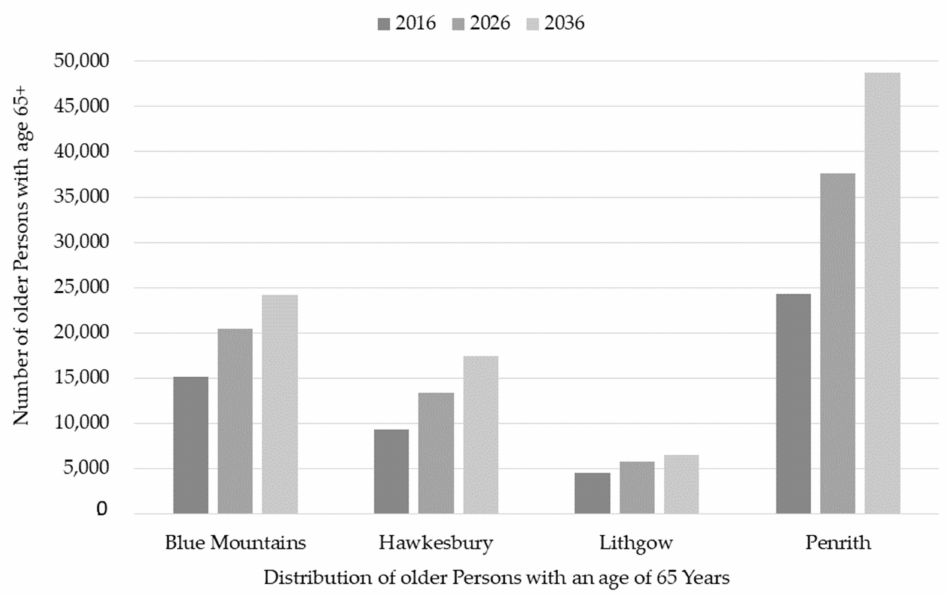
Figure 6. Distribution of older persons with an age of 65 years and above in the Nepean Blue Mountains according to LGA from the years